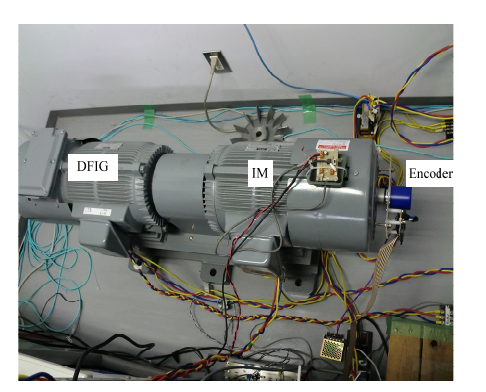
Figure 9. A photo of the experimental rig. Figure 8. Schematic diagram of the experimental setup.